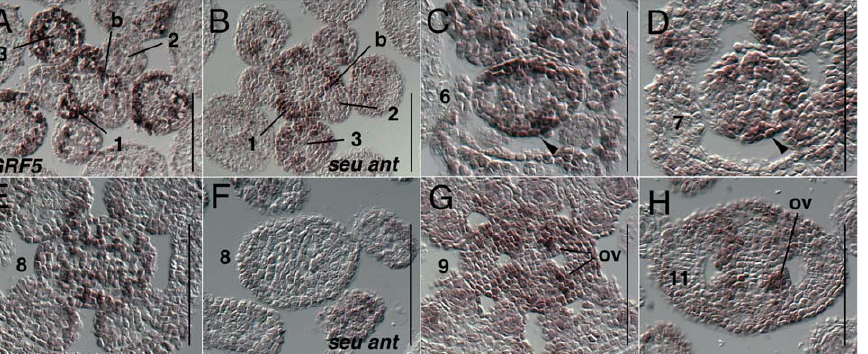
Figure 9. Results of insitu hybridization with AtGRF5 ( AT3G13960 ) antisense probe. Numbers indicate floral stages. All panels show transverse (cross sectional) tissue orientation. Arrowheads indicate medial domain expression. ov - ovule; b - boundary region between floral meristem and inflorescence meristem. Scale bars in all panels are 100 microns. All panels are Col-0 wild type tissue except as otherwise noted.